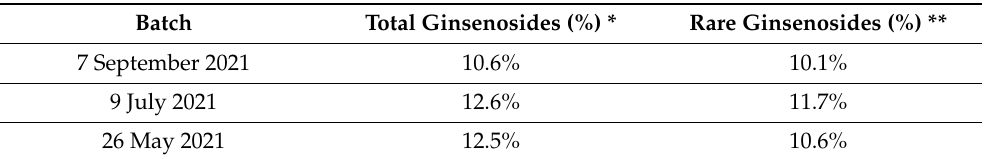
Table 8. HRG80 Red Ginseng: Consistency between Batches. Three random recent batch reports were picked to compare the amounts of total ginsenosides and rare ginsenosides between batches of the HRG80 ginseng. Results are as follows.